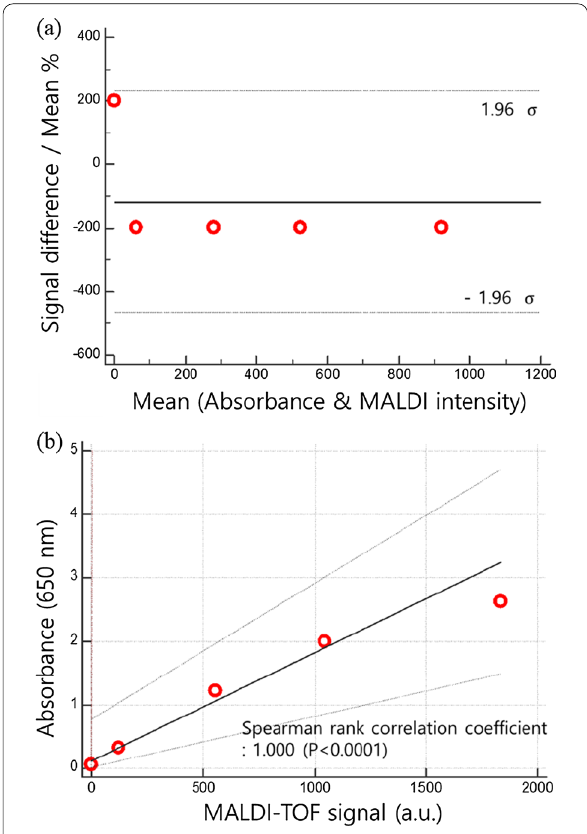
Fig. 5 Statistical analyses to estimate the consistency between MALDI‑TOF MS based on TiO 2 nanowire chip and OD measurement from enzyme immunoassay using galactose oxidase in the a Bland– Altman test and b Passing–Bablok regression for the correlation